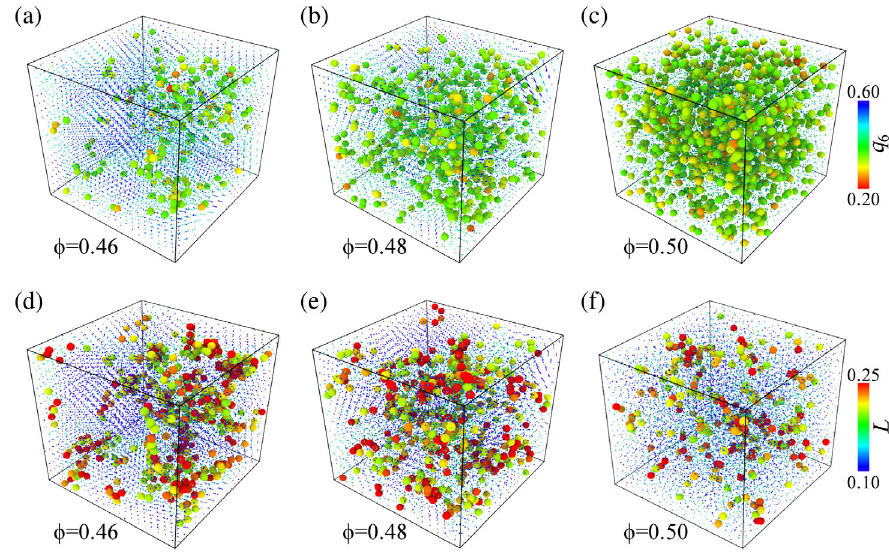
FIG. 10. (a) – (c) Weighted bond-orientational order parameter q 6 and (d) – (f) Lindemann parameter L at ϕ ¼ 0 . 46 , 0.48, and 0.50, respectively. Particles with q 6 > 0 . 35 and L < 0 . 20 are shown as the small blue dots for the better visualization of disordered (i.e., small q 6 ) and strong moving (i.e., large L )